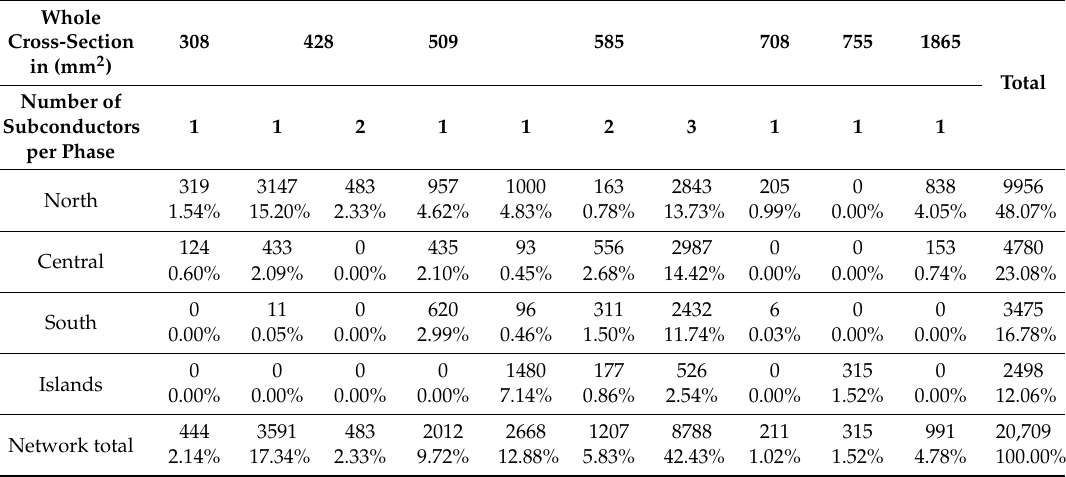
Table 2. Detail of the Italian EHV Transmission network extension divided by cross-sections (mm 2 ) and number of subconductors per phase of aluminium conductor steel reinforced (ACSR) conductors in (km) and in (%).